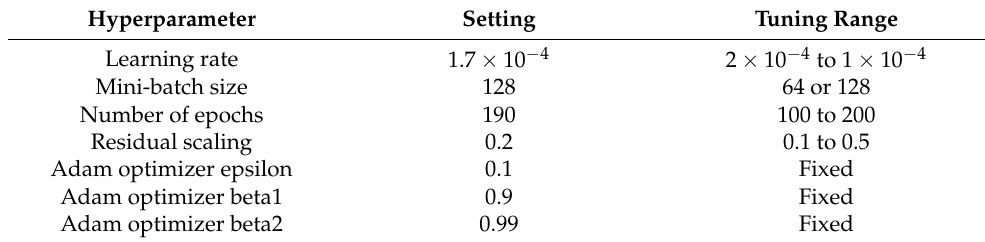
Table A1. Optimized hyperparameter